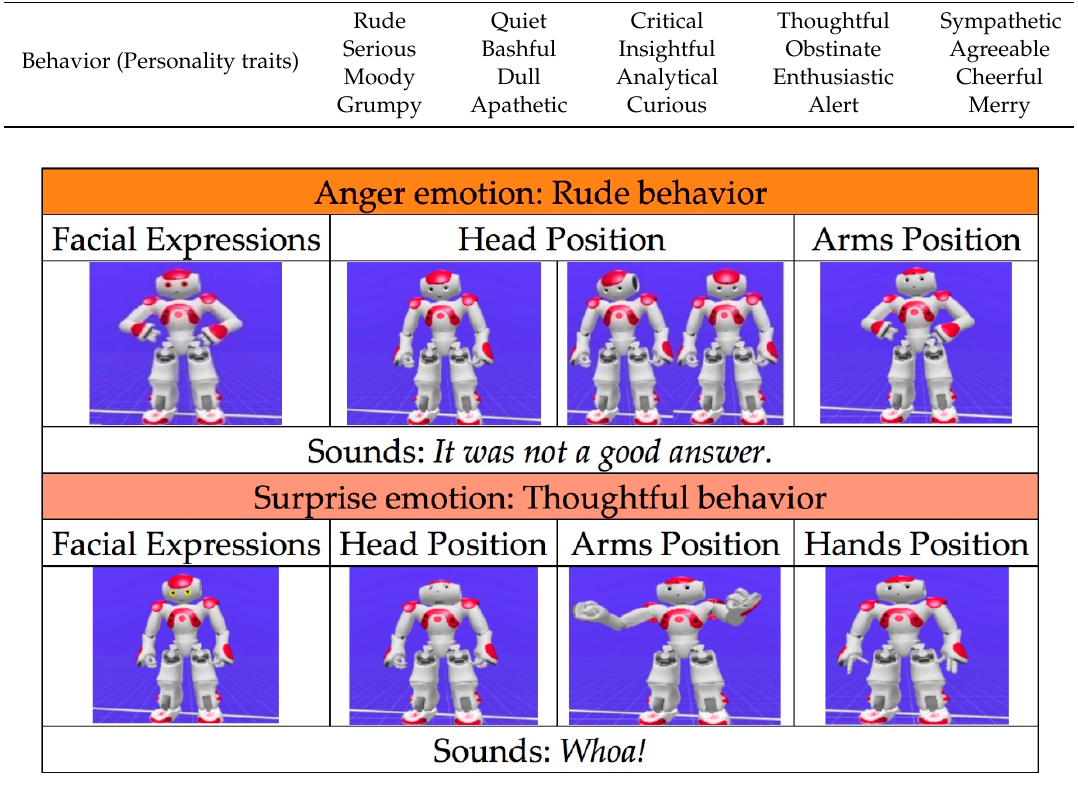
Figure 2. Example of the construction of behaviors at Level 2.